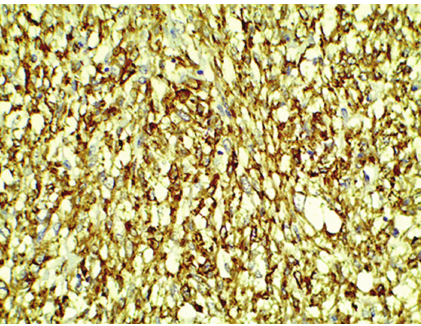
Figure 3: Tumor cells revealing di ff use immunoreactivity to smooth muscle actin (IHC for smooth muscle actin